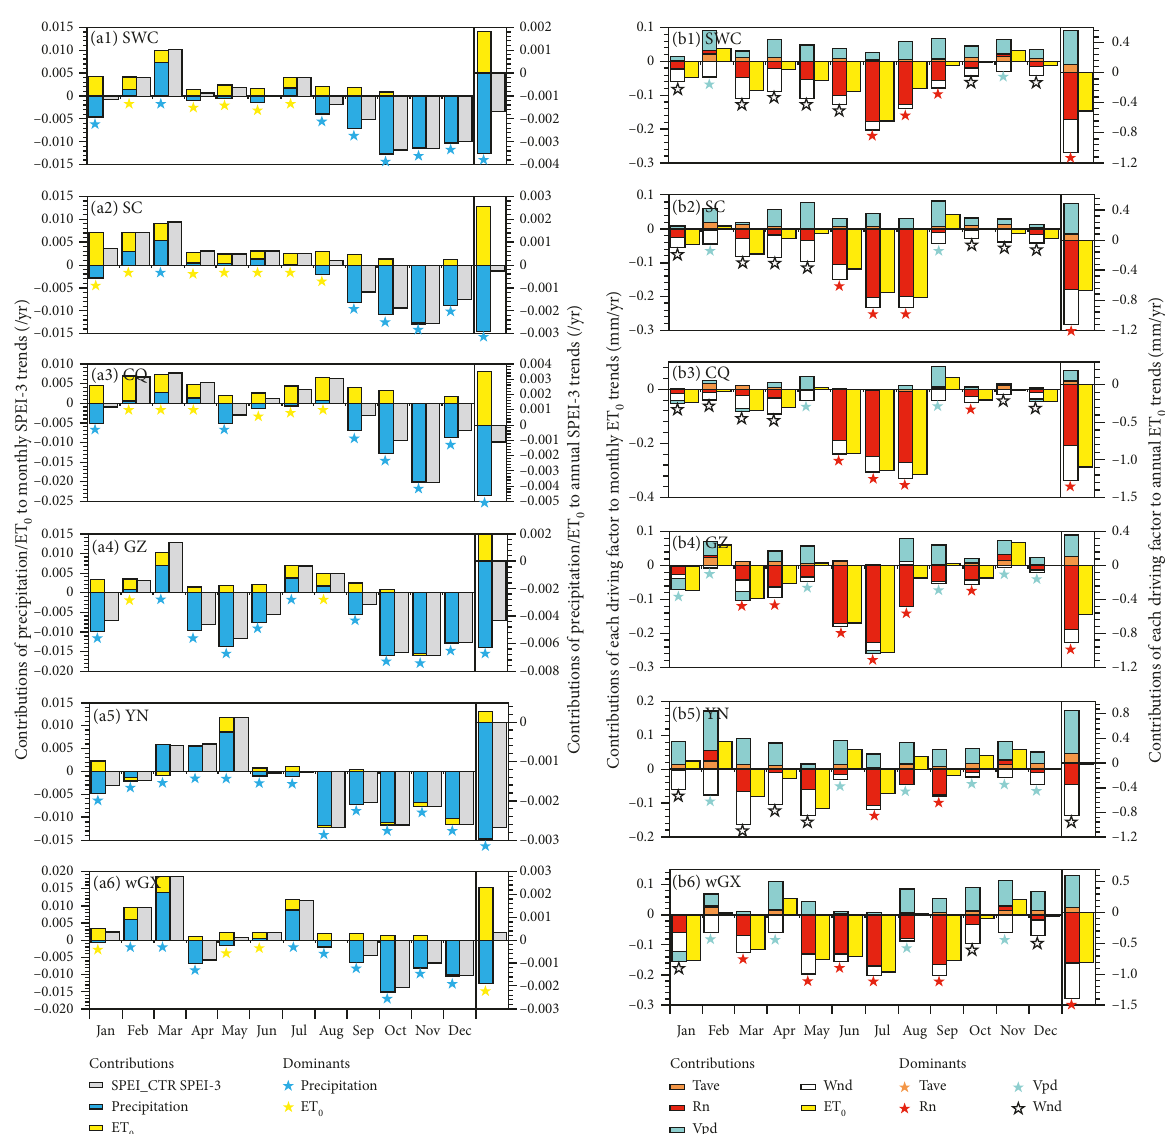
Figure 5: Monthly and annual regional mean contributions of precipitation and ET 0 alone to SPEI-3 changes (a1–6) and those of the driving factors alone to ET 0 trends (b1–6) during 1961–2012. For each panel, left and right y axes show monthly and annual